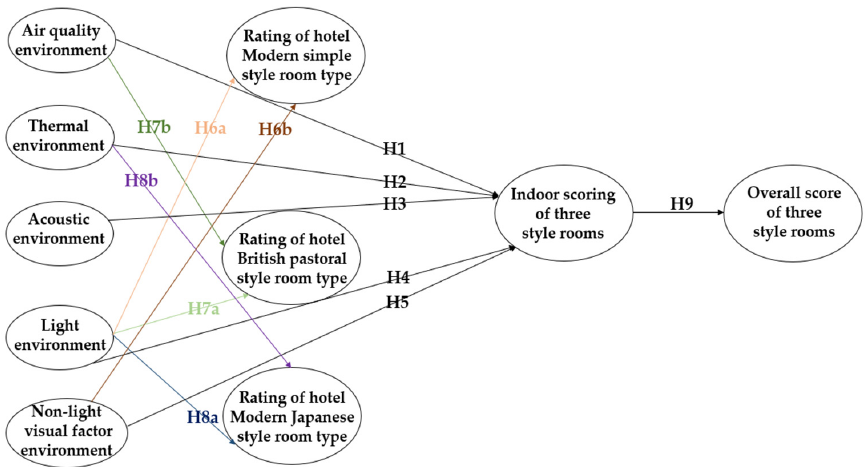
Figure 5. Analysis model